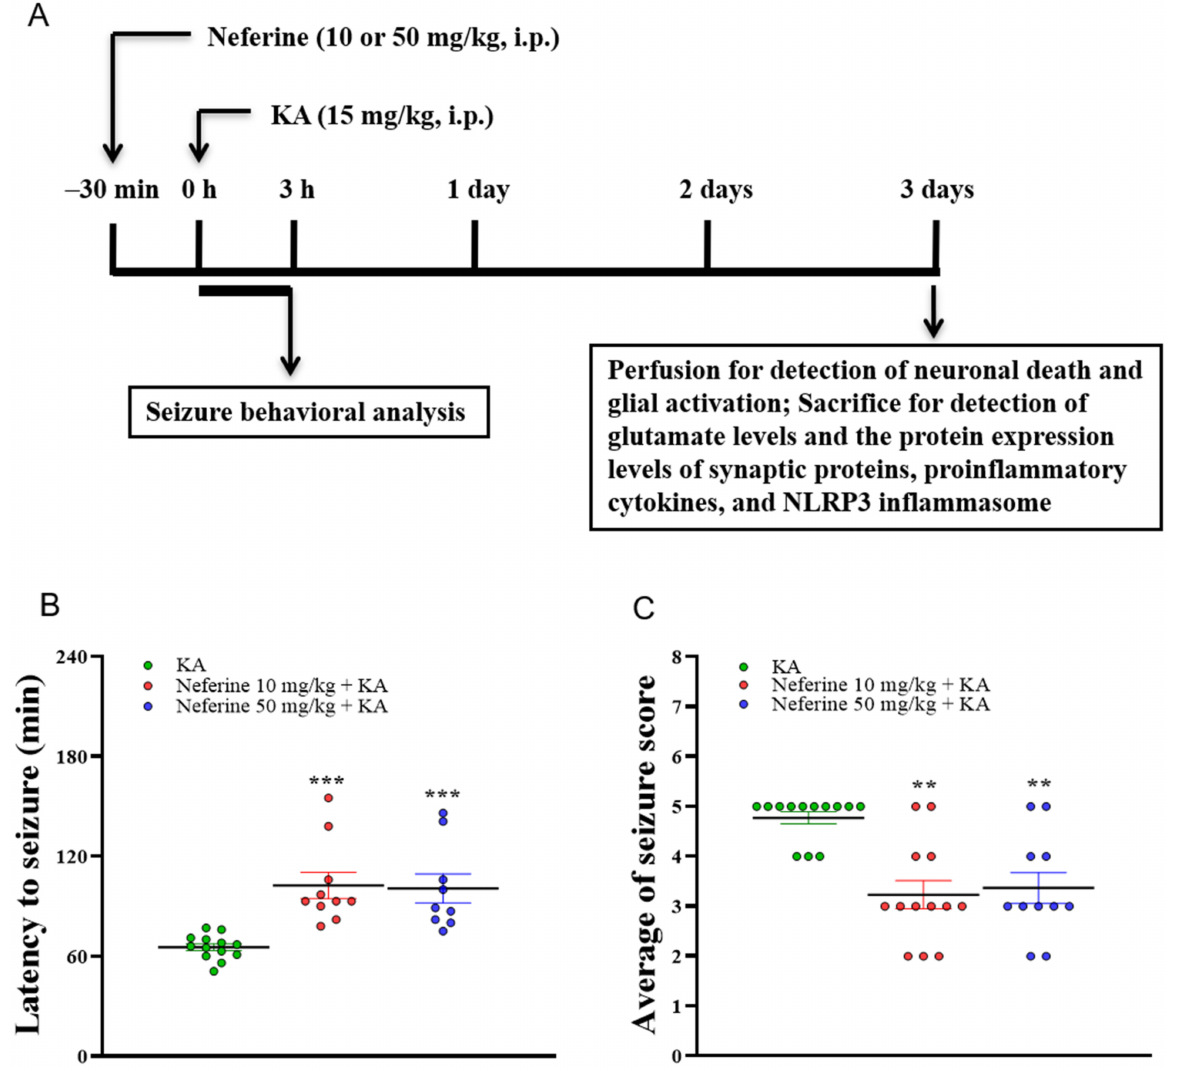
Figure 1. Neferine reduces KA-induced seizure activity. ( A ) Experimental design. ( B , C ) Seizure behavior analysis in the different groups ( n = 9–13 rats/group). Statistical results showed that neferine increased the latency of seizures ( B ) and decreased seizure score ( C ) (one-way ANOVA). ** p < 0.01, *** p < 0.001 vs. KA-treated